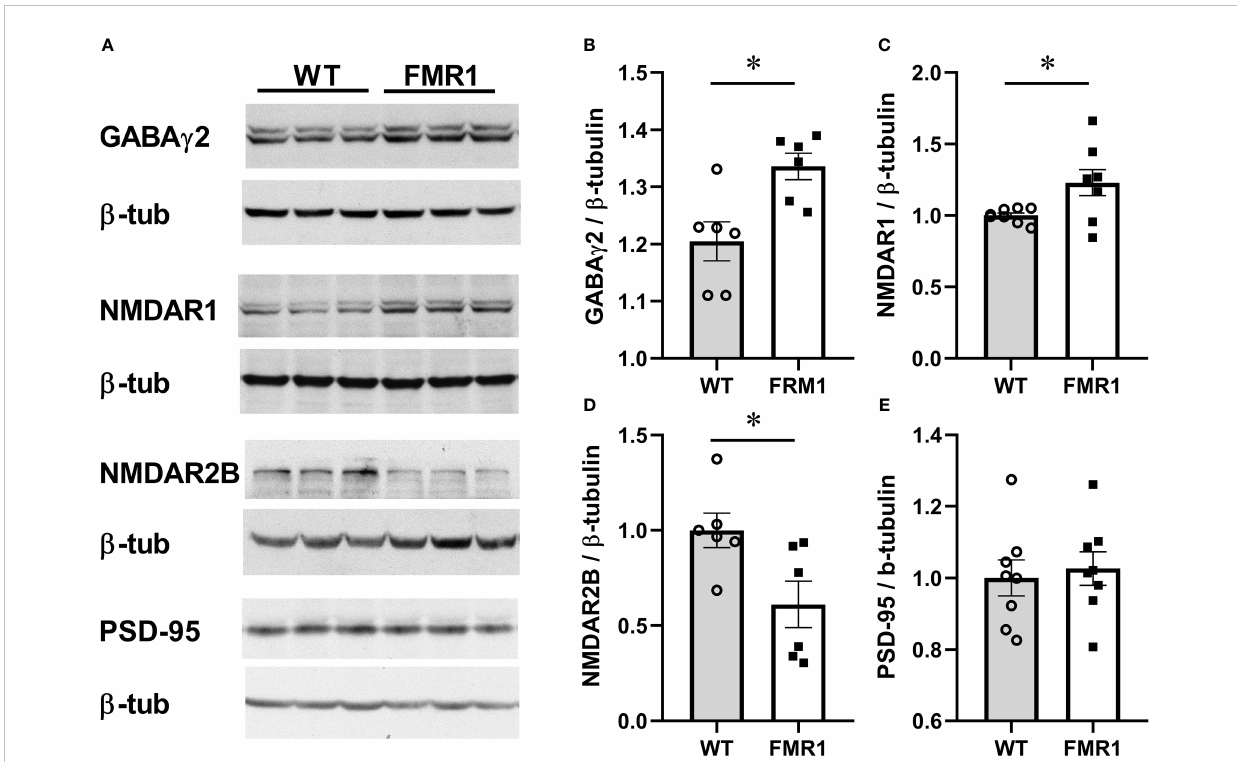
FIGURE 8 Fmr1 KO females have higher levels of the obligatory GABA A receptor subunit in hypothalami. Hypothalami were dissected and protein levels analyzed by western blotting. Representative blots are shown in (A) . Protein levels from 6 mice per group were quanti fi ed using Chemidoc and levels of neuronal proteins normalized to b -tubulin (B – E) . Statistical signi fi cance (p < 0.05), determined with t-test followed by Tukey ’ s post hoc test, is indicated with a